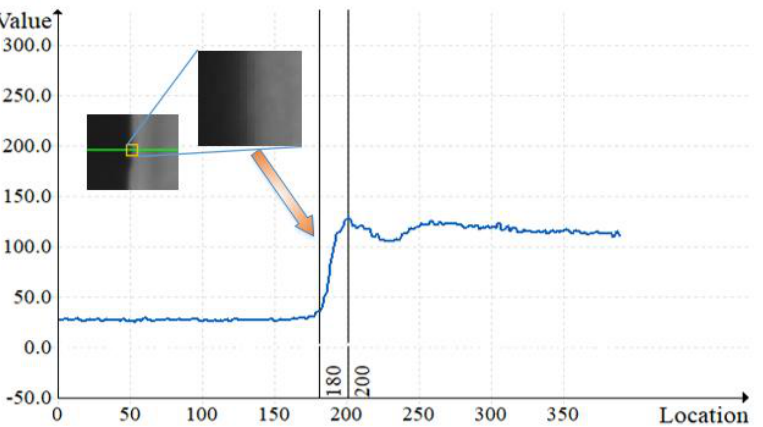
Figure 7. Diagram of grayscale